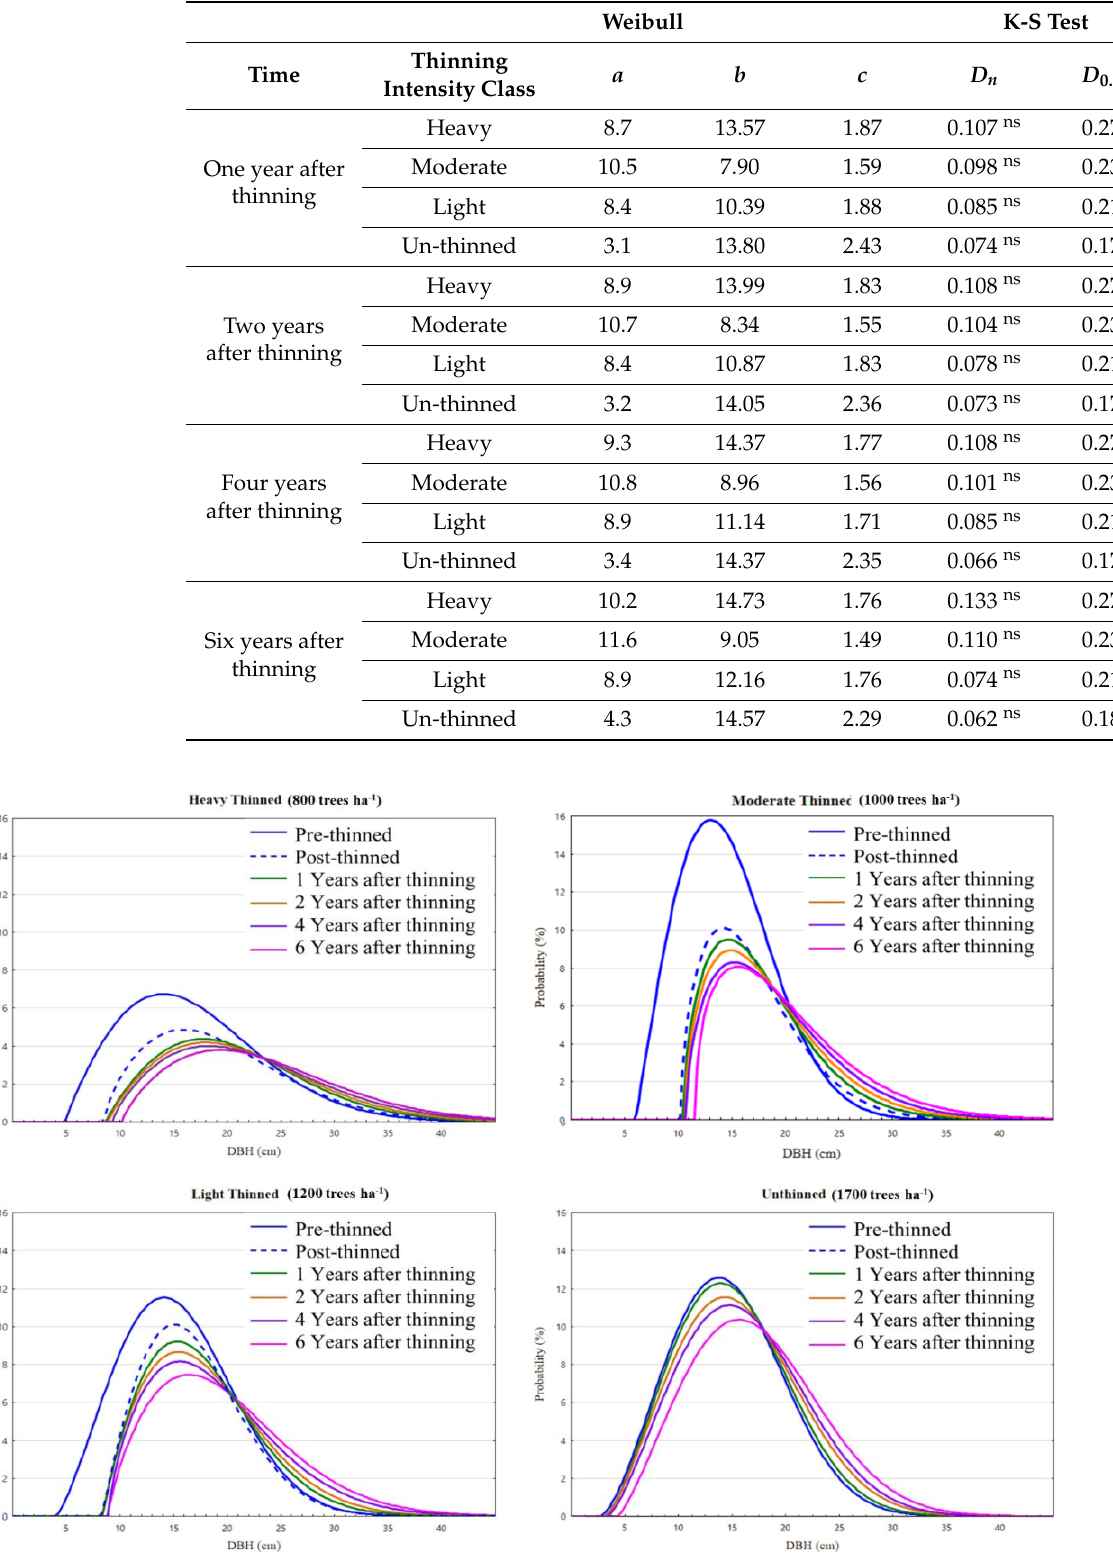
Figure 4. The distribution of diameter at breast height (DBH) among different thinning treatments of Honduras mahogany of an age of 14 in the Guanmiao Farm in Guanmiao, Taiwan before and after